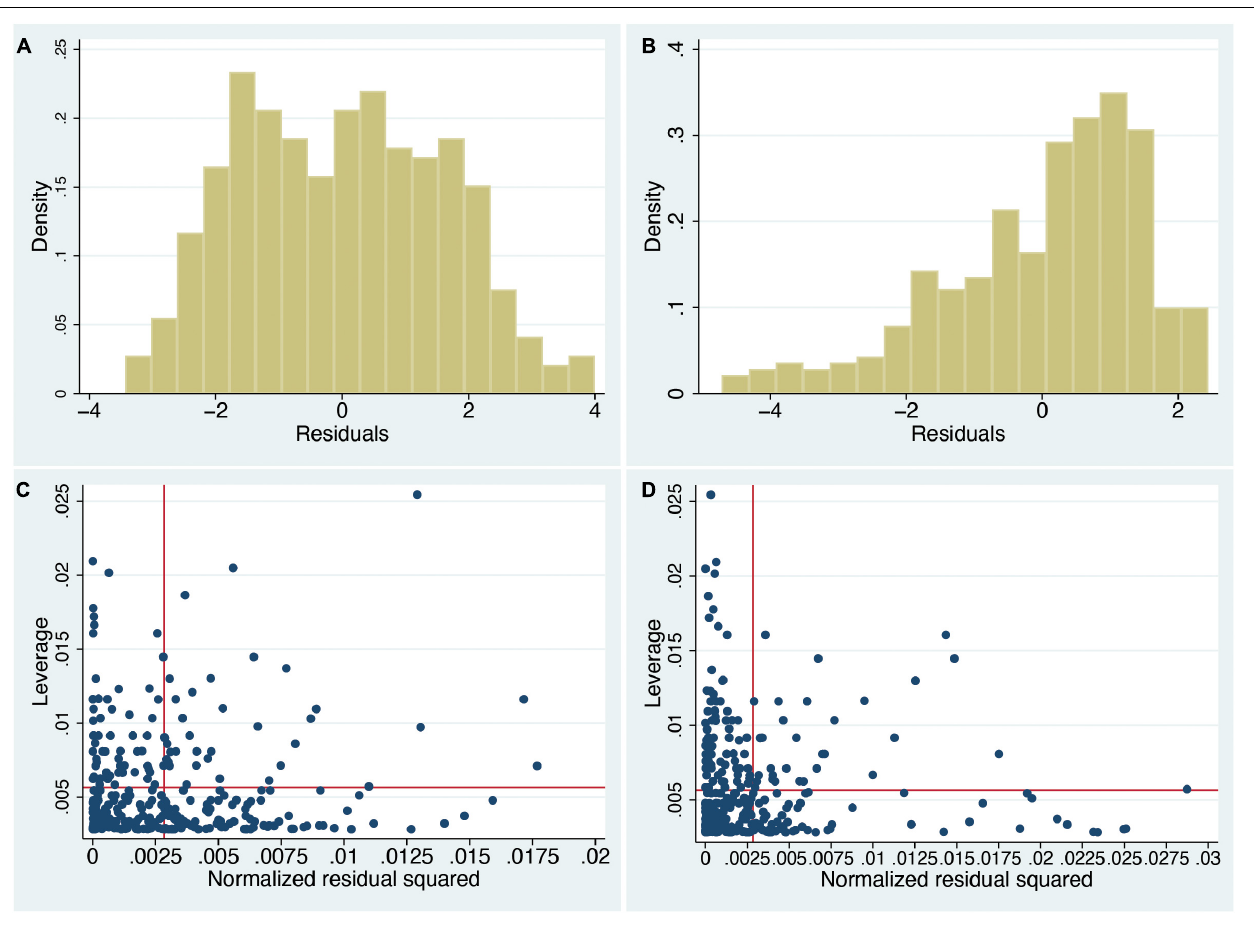
FIGURE 1 | Histograms of residual errors of the regression fits and leverage plots of the normal linear regression analyses ( n = 353). (A) sa on swash , (B) ss on swash , (C) leverage plot of sa on swash , and (D) leverage plot of ss on swash . sa and ss denote the RHI questionnaire scores in the asynchronous ( sa ) and synchronous ( ss ) conditions, respectively. Density (y-axis) is the empirical probability density so that areas under the histogram correspond to probabilities. Residual errors are the differences between the fitted and observed values (x axis). Note that if swash would explain all variance in the RHI ratings, then the residuals in panels (A,B) should be similar and centred around 0, but as can be seen, there are clear differences with ratings tending to higher values in ss (B) . Panels (C,D) show the normalised squared residuals (x axis) against the leverage values (y axis). The vertical line shows the mean of the normalised squared residuals and the horizontal line the mean leverage. High leverage values are especially important, since they indicate that the corresponding data points are very influential in the sense that they strongly influence the regression fit, whereas high residual errors show points that are far from the regression line. It can be seen that there are some very high leverage values, more than 2 or even 3 times the mean leverage, and likewise some very high residual errors, more than 2 or 3 times their